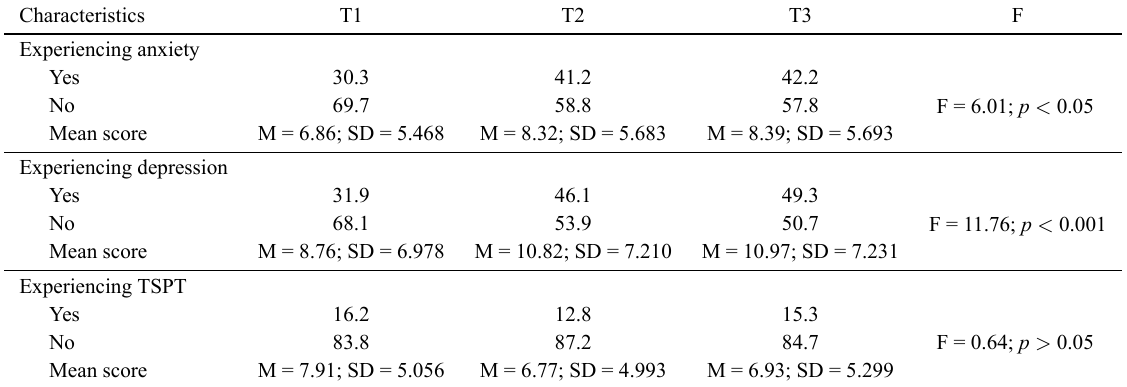
Table 2. Mental health of